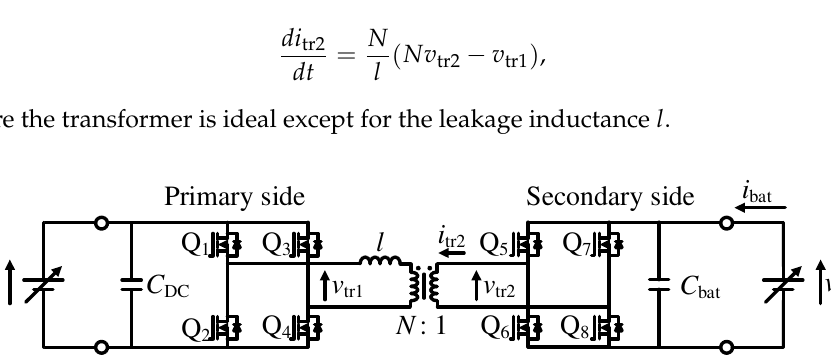
Figure 5. Simplified circuit configuration of DAB converter in battery-discharging mode without power generated by wind turbine.